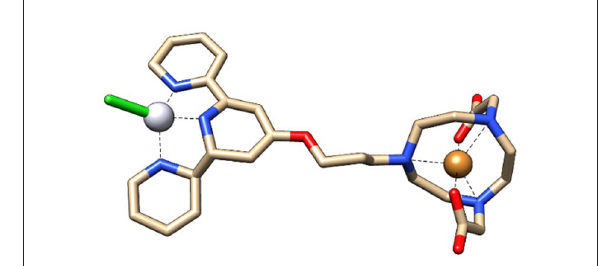
FIGURE1 3D Structure of [ 64 Cu]Cu-C3-NOTA-TP conjugate (Chimera software